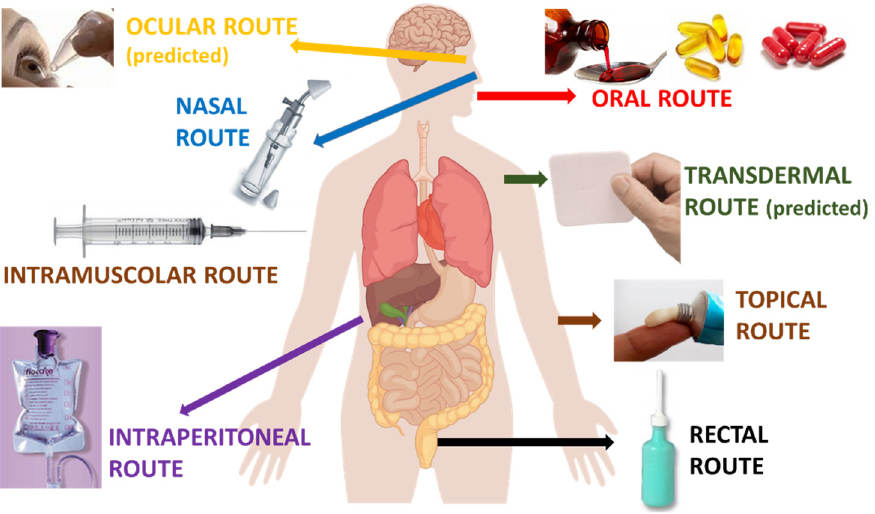
Figure 4. Tested or predicted routes of administration of the developed CBD-loaded nanocarriers.